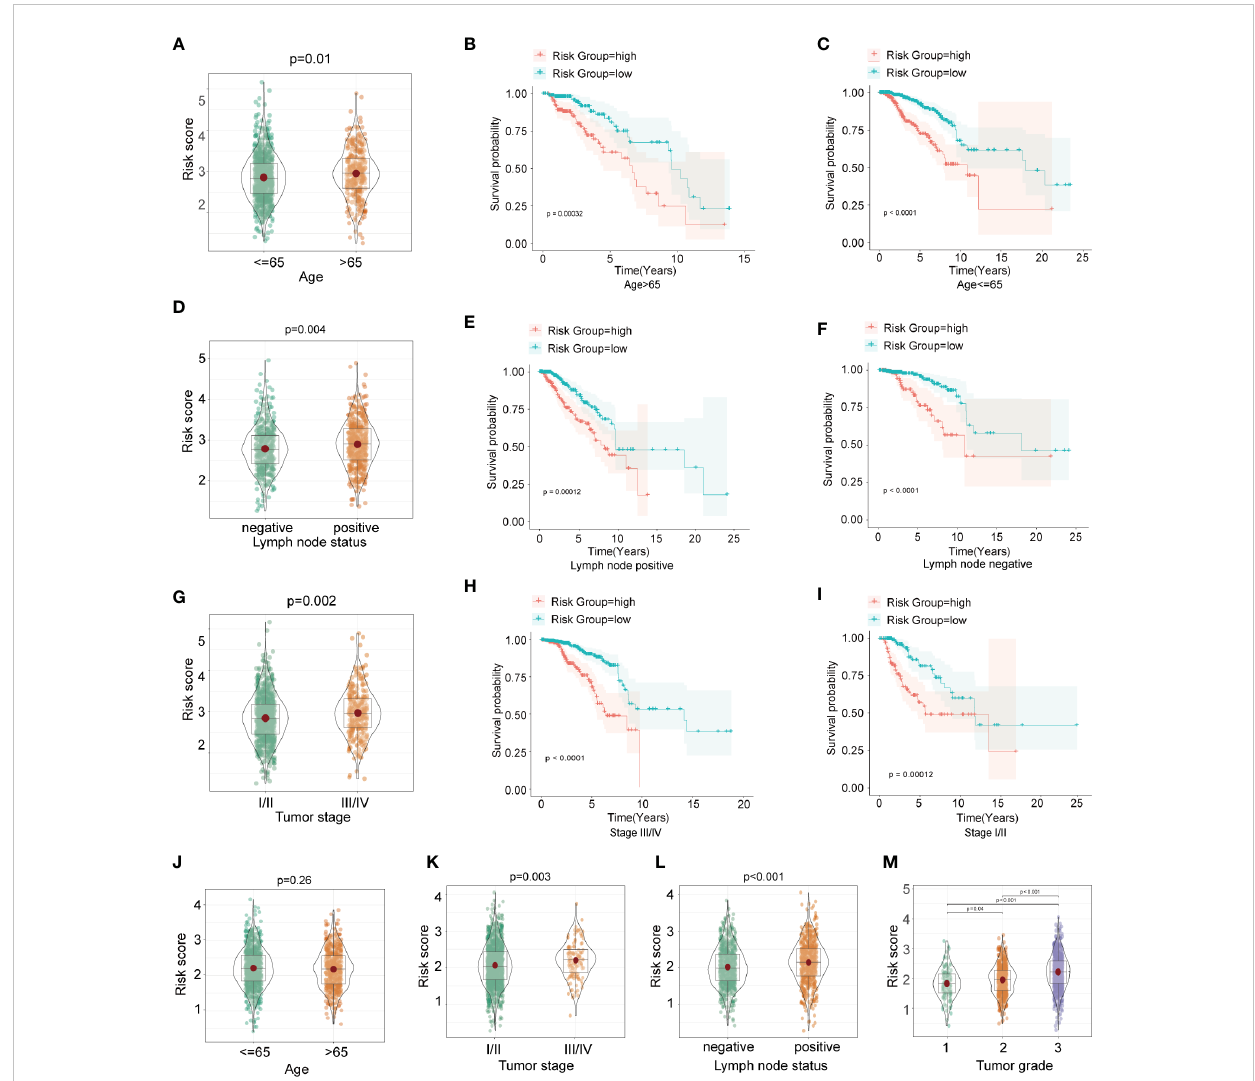
FIGURE 4 The relationship between HFRS score and clinicopathological features in BC patients. (A, D, G) The boxplots shows the comparison of HFRS risk score of BC subgroups strati fi ed with different clinicopathological features (age>65 or<=65; positive or negative lymph node status; III/IV or I/II tumor stage) in TCGA cohort. (B, C) Comparison of the overall survival of patients with high- and low- HFRS risk score in age>65 (B) and age<=65 (C) subgroups. (E, F) KM curves to show the different overall survival of patients with high or low HFRS risk scores in lymph node positive (E) and lymph node negative (F) subgroups. (H, I) Comparison the survival of patients with high or low HFRS risk score in tumor stage III/IV (H) and tumor stage I/II (I) subgroups. (J – M) The boxplots shows the signi fi cant difference HFRS risk score levels of patients with different clinicopathological features(age, tumor stage, lymph node status and primary tumor grade) in METABRIC